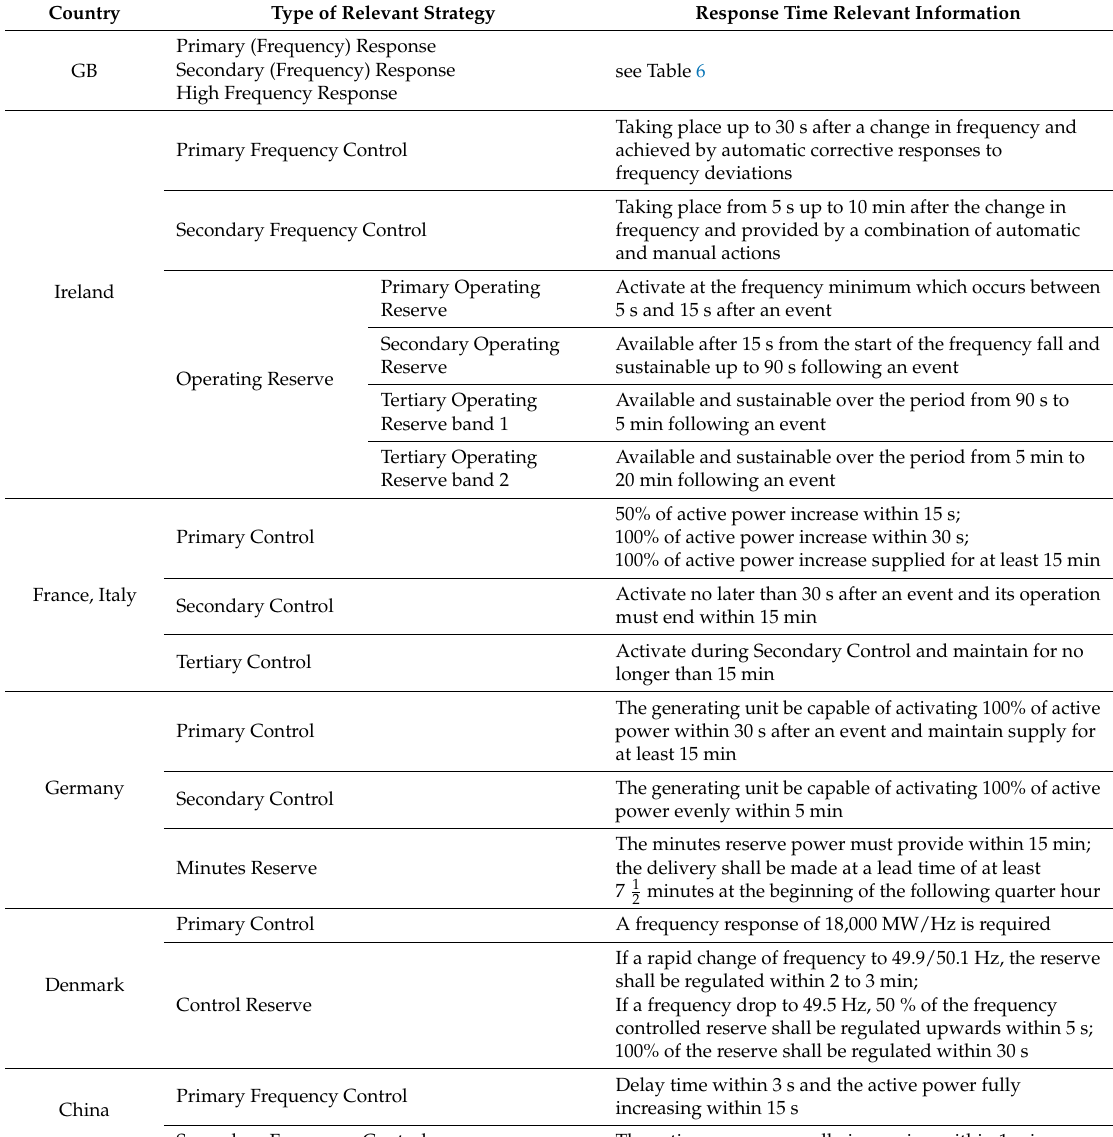
Table 7. Comparison of frequency control strategies